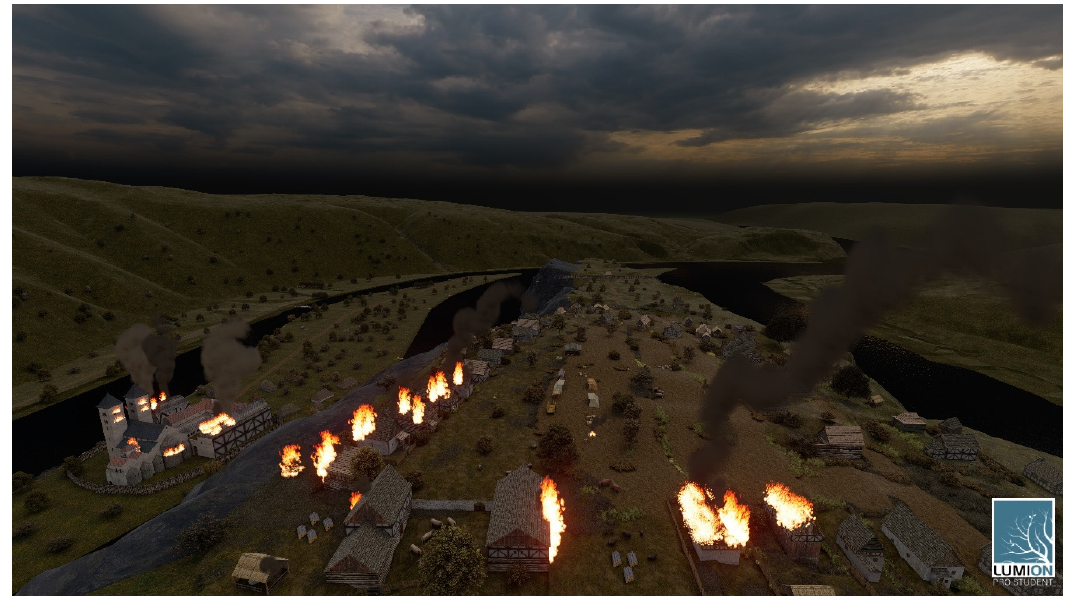
Figure 9. Illustration of the incursion of the Brandenburgers. ISPRS Int. J. Geo-Inf. 2020 , 9 , x FOR PEER REVIEW